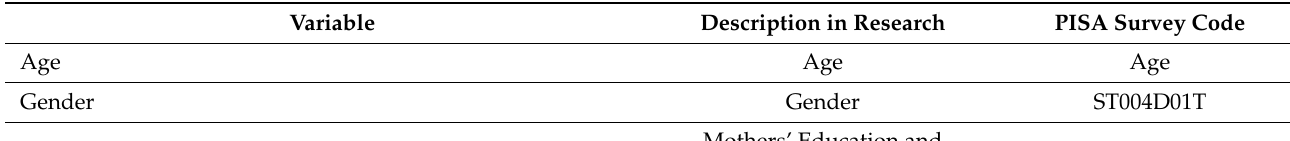
Table 2. The list of the variables used in this